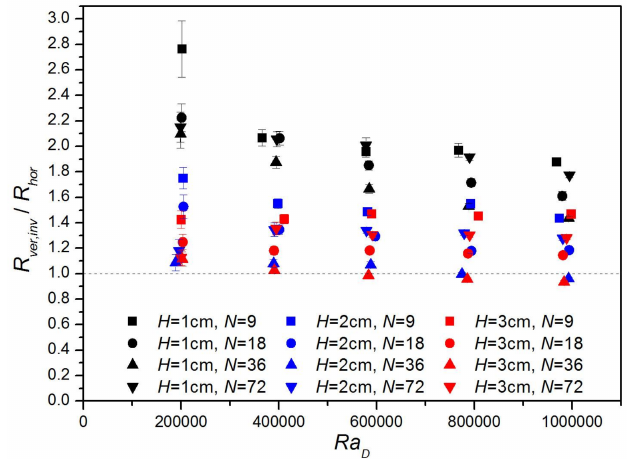
Figure 15. Ratios of thermal resistances of inverted vertical cylinders with triangular fins to those of horizontal cylinders with triangular